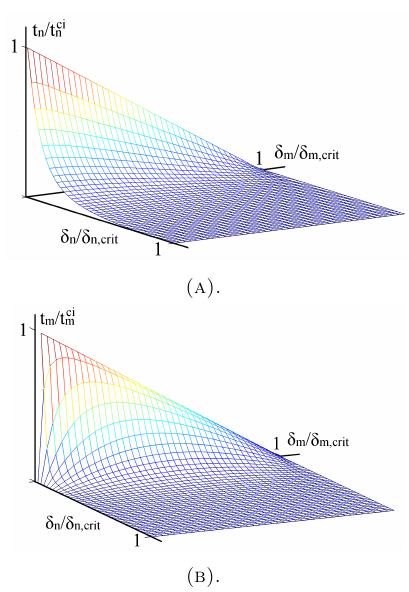
Figure 1. Cohesive law in (A) crack-normal direction t n ( δ n , δ m ) with fracture energy G f as an integral of t n ( δ n , δ m ) and (B) crack-tangent direction t m ( δ n , δ m )